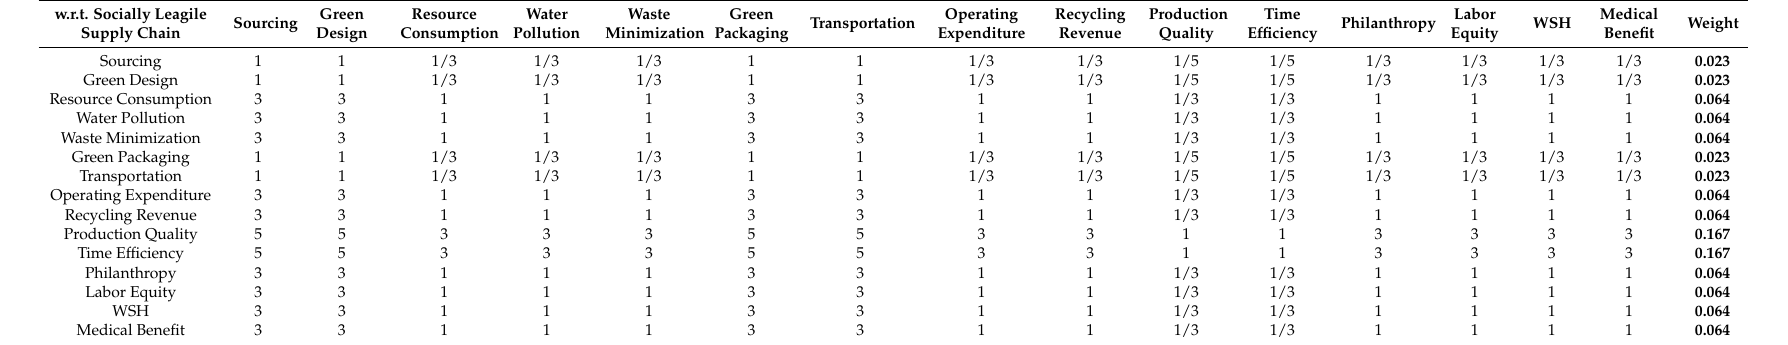
Table 13. Pairwise comparisons of the criteria w.r.t. Reverse Logistics.